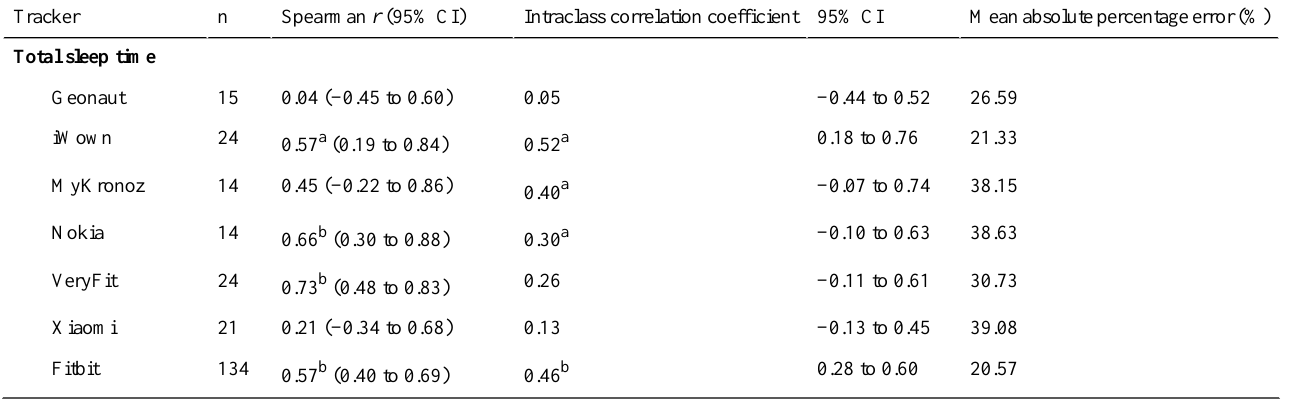
Table 5. Correlation coefficients, intraclass correlation coefficients, associated 95% CI of the measurements, and mean absolute percentage error scores for measuring total sleep